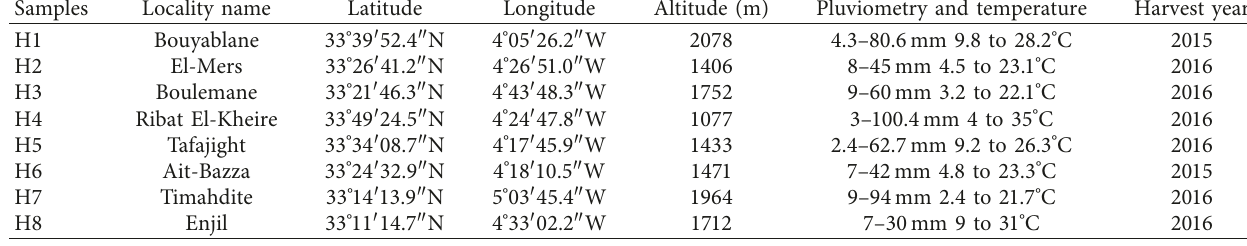
Table 1: Geographical locations of honey samples studied.